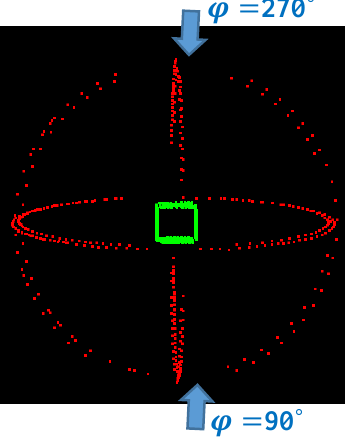
Figure 13. A 3D display of the image positions (in red) and the calibration-targets (in